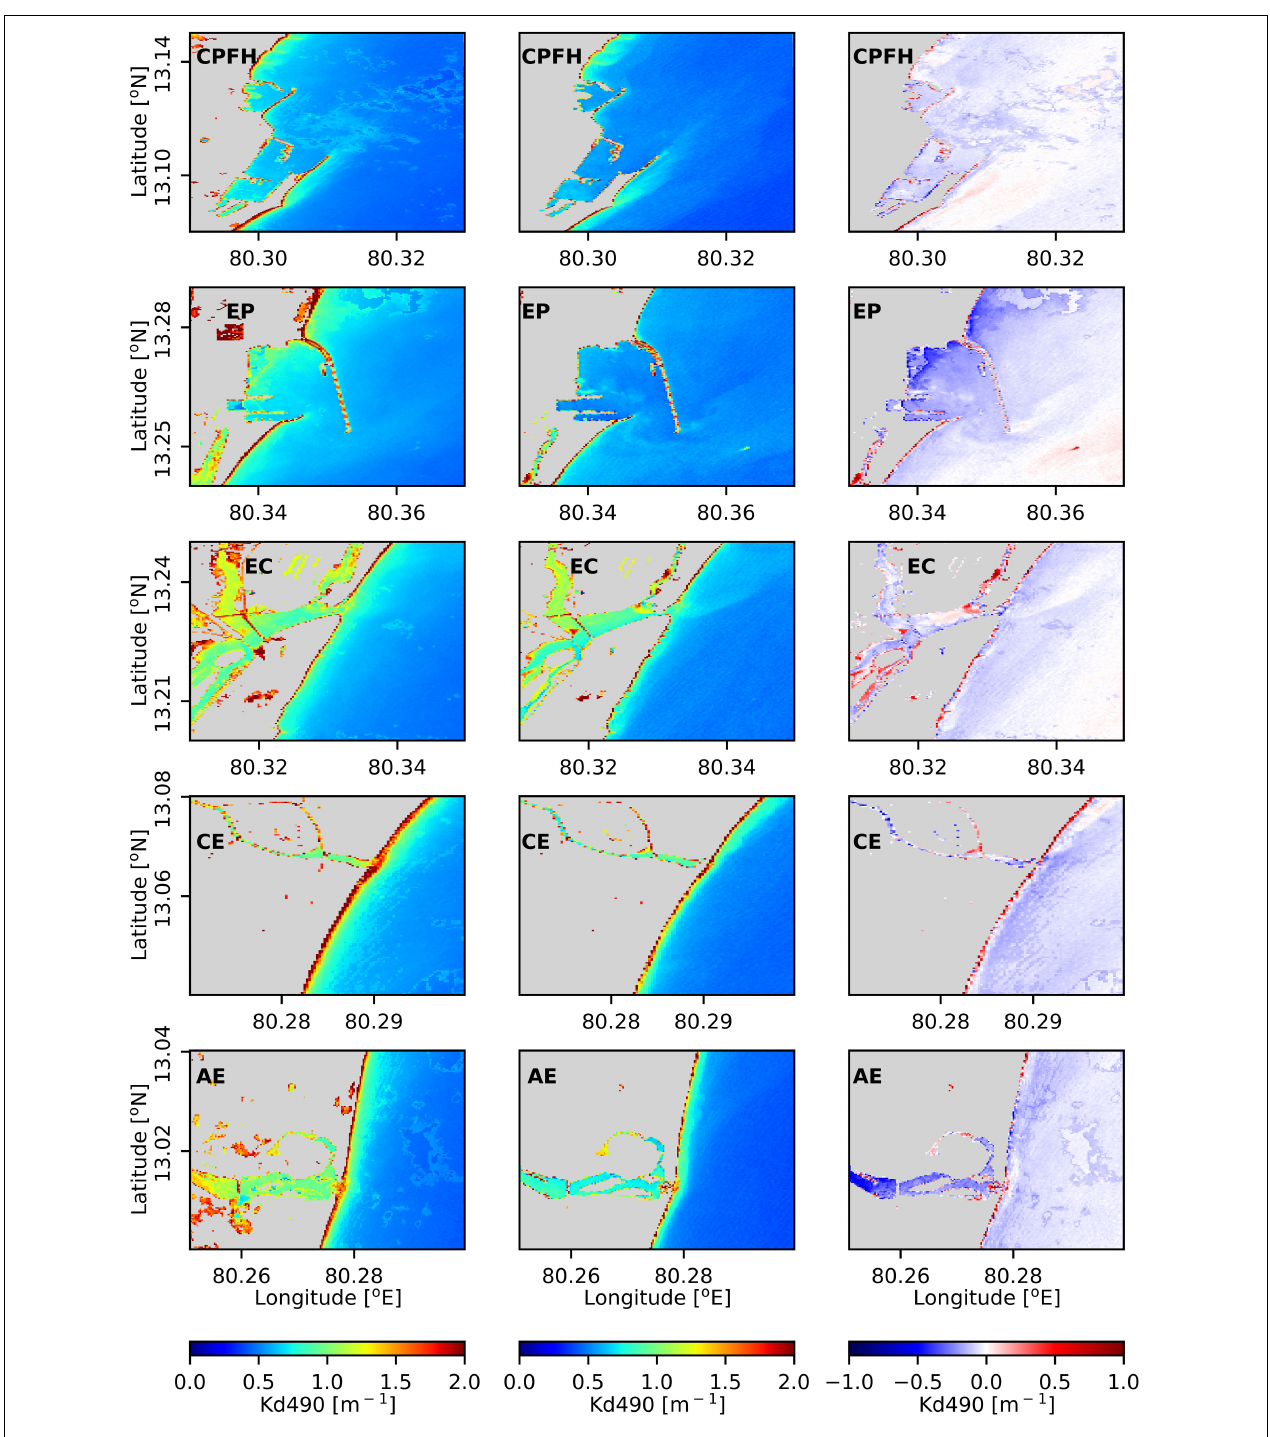
FIGURE 4 | Long-term (left), April 2020 (middle), and April 2020 anomaly (right) mean distributions of K d (490) over prominent regions in the study